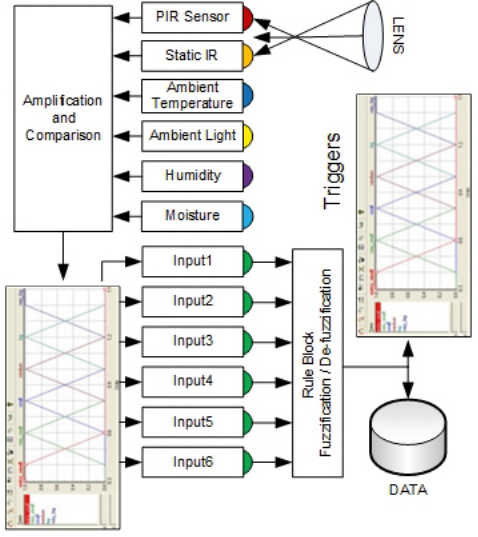
Figure 3. Original fuzzy logic system model. Recent model addition includes Radar